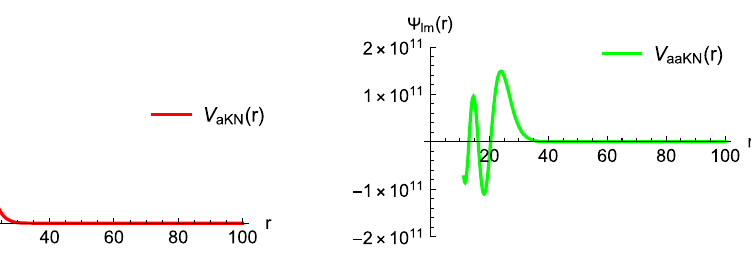
Fig. 8 Radial modes (cid:13) lm as function of r ∈ [ 11 . 3 , 100 ] with trapping well: (left) quasi-bound state with V aKN ( r ) and (right) oscillation with V aaKN ( r ) . All parameters go together with Fig.